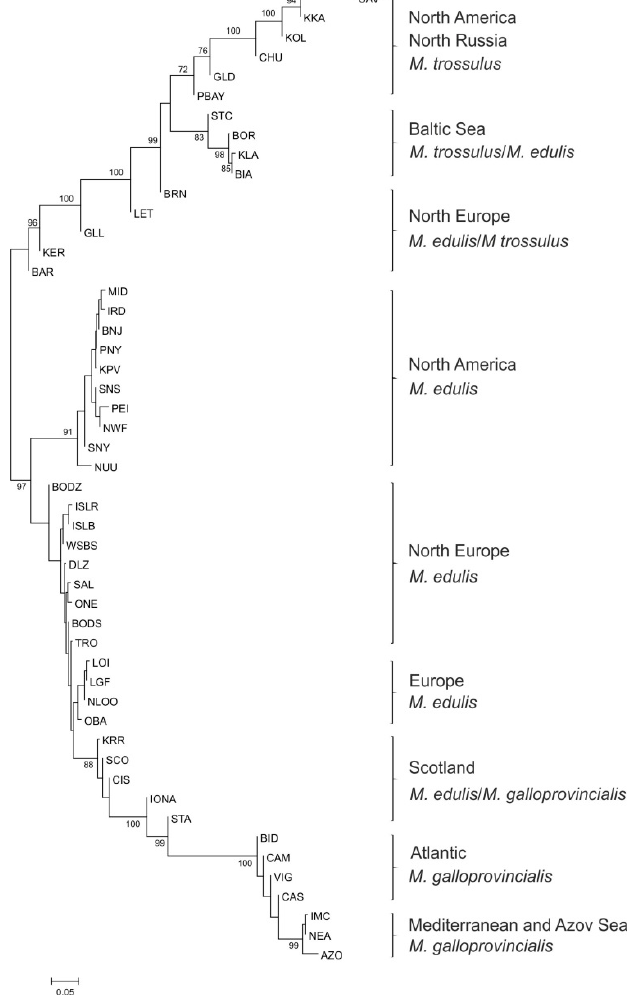
Figure 2. Neighbor-joining tree of 50 Mytilus populations based on the F ST distance matrix from allele frequencies of the nucleotide polymorphism (SNP) loci. Population codes as shown in Table 1.